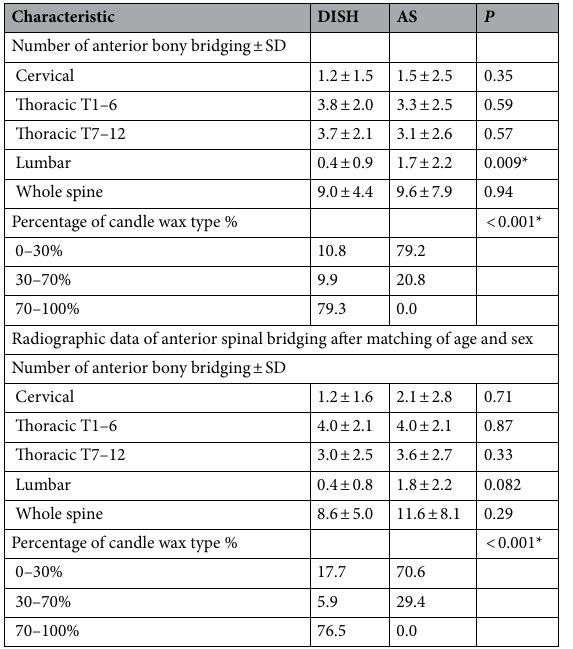
Table 3. Radiographic data of anterior spinal bridging. DISH Diffuse idiopathic skeletal hyperostosis, AS Ankylosing spondylitis, SD: standard deviation. * P <